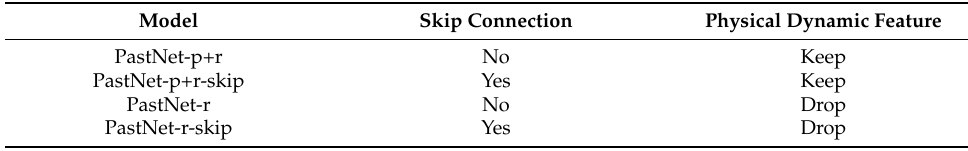
Table 1. Set-up of four versions of PastNet. PastNet-p+r decodes physical dynamic feature to h p and adds it to h r to compose ˆ h r . PastNet-p+r-skip has a skip connection from h r t + 1 t + 1 t + 1 ˆ h r . PastNet-r drops h p after the attention gate and only keeps h r to feed in the final decoder. t + 1 t + 1 t + 1 PastNet-r-skip adds a skip connection between h r and ˆ h r on PastNet-r. t + 1 t + 1